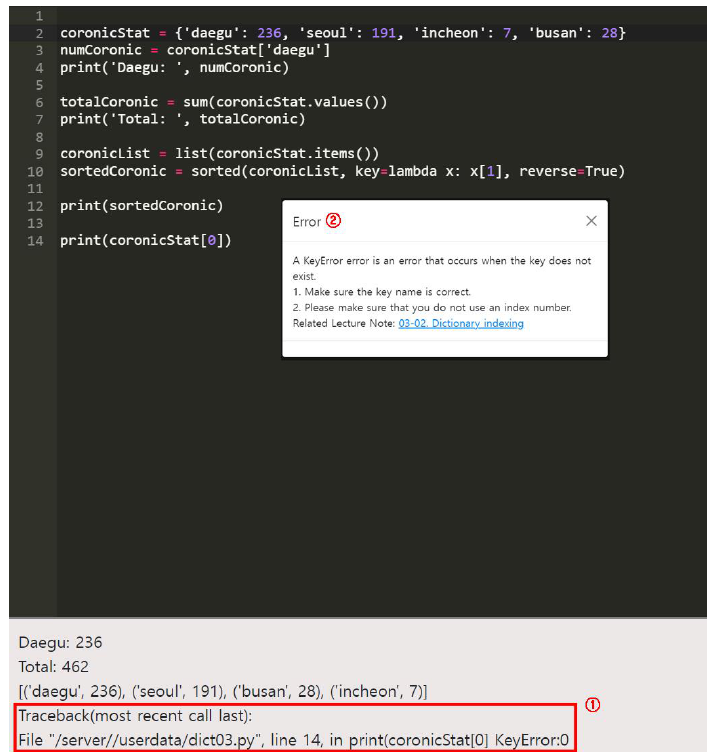
Figure 5. Related error guide message and links to lecture and tutorial. ① The error message returned by the interpreter (compiler) when a source code error occurs. ② Error guidance messages for each error pre-registered by the instructor in the learning analytics cloud server. Appl. Sci. 2022 , 12 , 5412